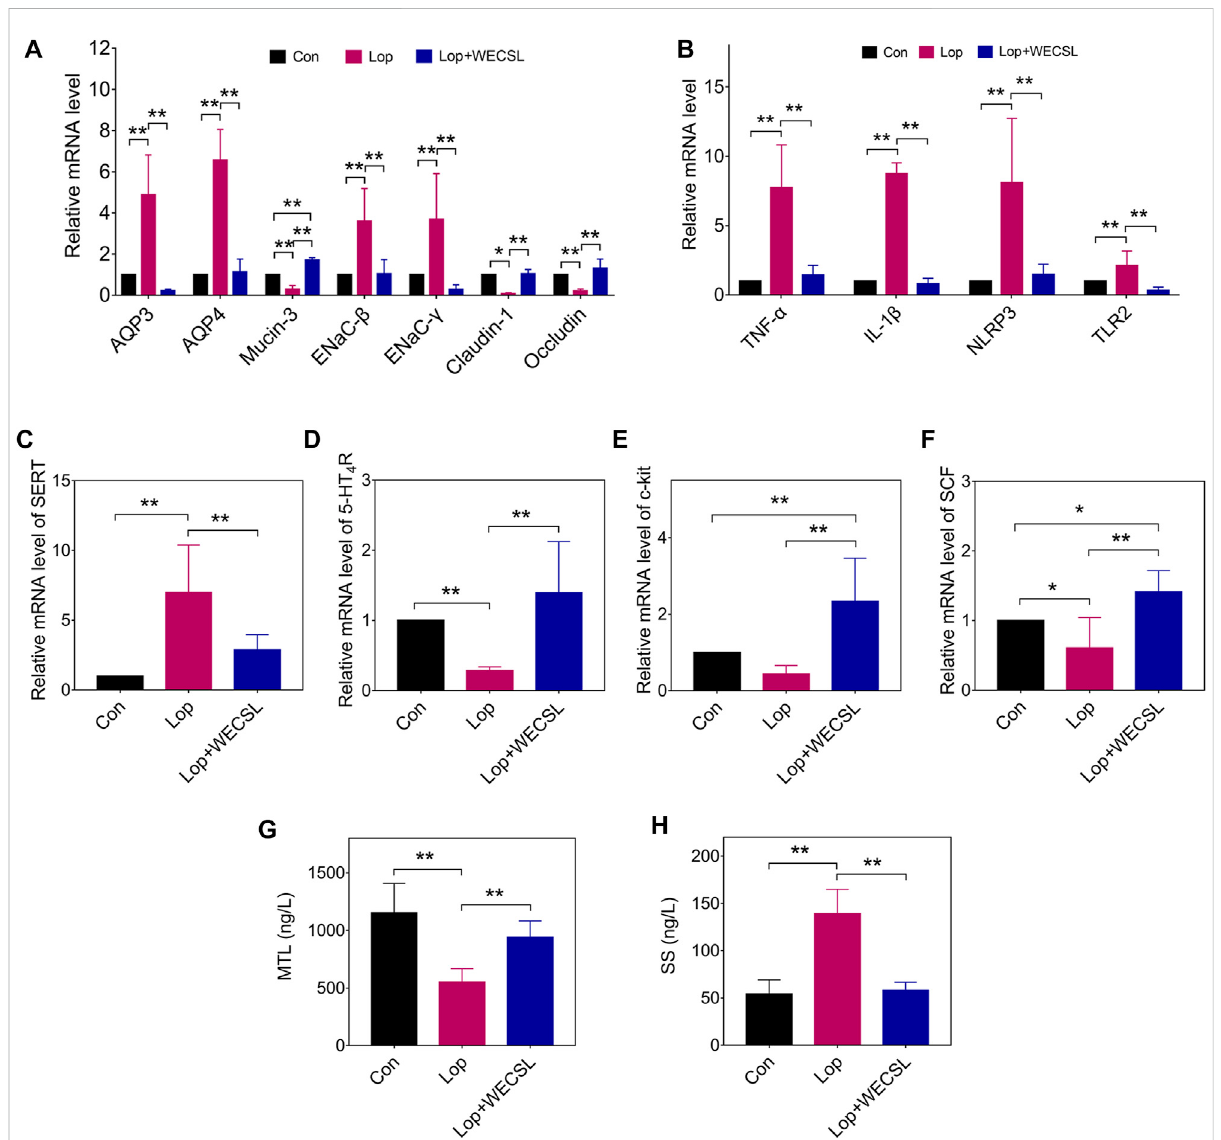
FIGURE 3 WECSL regulated disorderes of intestinal function in constipated mice. (A) mRNA levels of water transport-related and gut-barrier-related proteins detected using RT-qPCR. (B) mRNA levels of in fl ammatory factors, SERT (C) . 5-HT 4 R (D) , and SCF/c-kit signaling pathway proteins c-kit (E) andSCF (F) usingRT-qPCR. (G,H) SerumMTL (G) andSS (H) levelsdetectedusingELISA.Dataarepresentedasmean±SD( n =8pergroup).* p < 0.05, ** p <